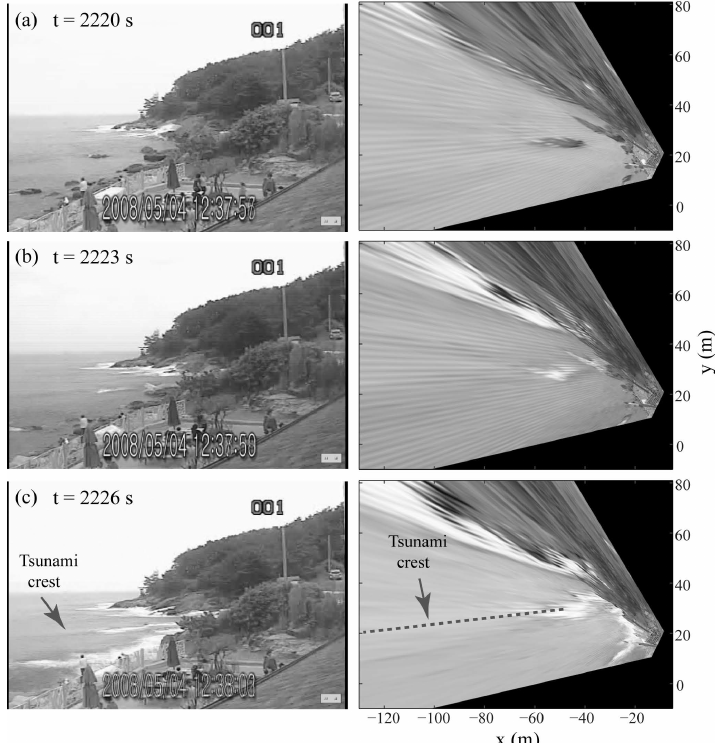
Fig. 7. Sequential images of the largest abnormal wave propagating the coastal pocket mouth area during the tsunami episode. (Left panel) three successive images with a time interval of 3 s, and (right panel) their rectified